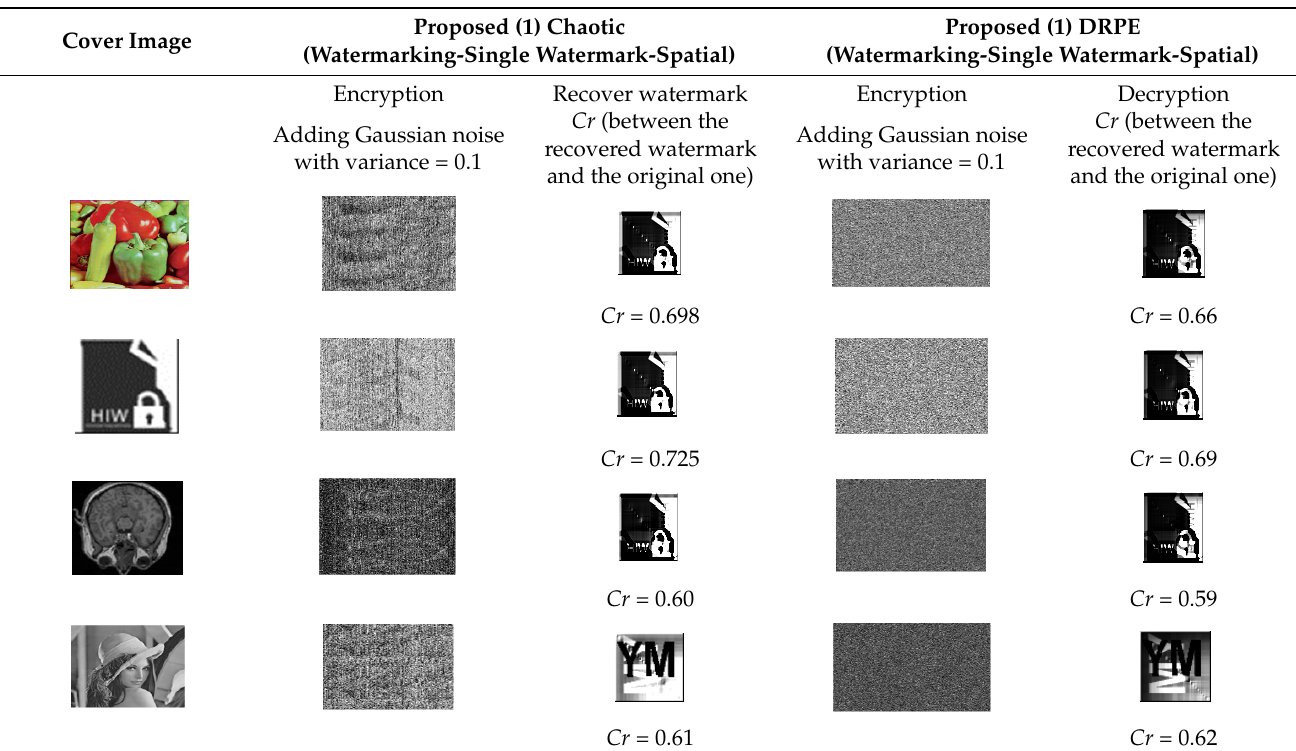
Table 15. Gaussian noise images and corresponding extracted watermarks for proposed technique